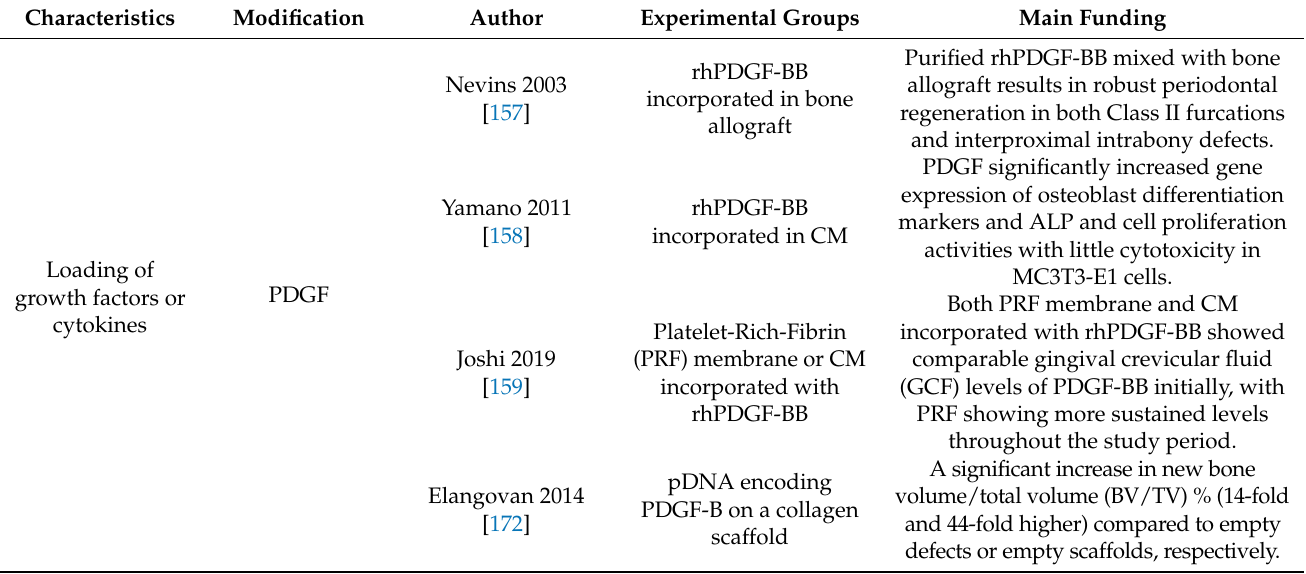
Table 2. Recent advances of barrier membranes in combination within bioactive